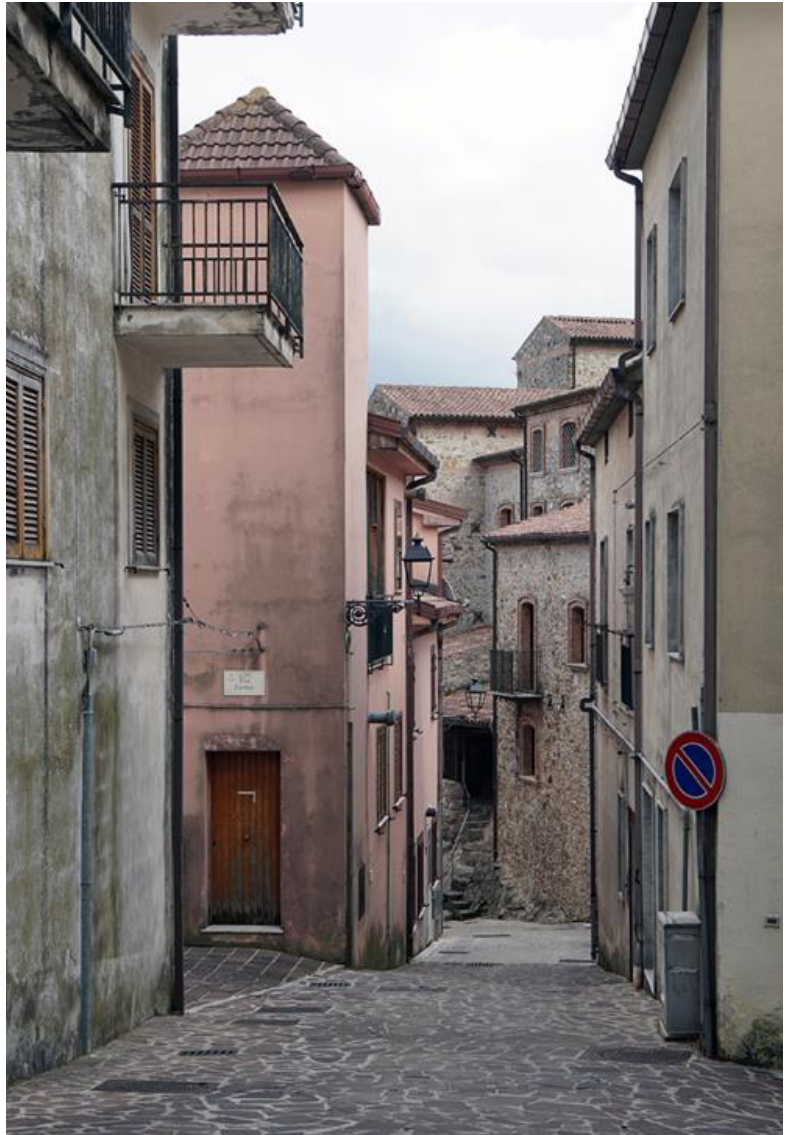
Figure 53. Quaglietta: detail of the medieval village (photos by [35,36]).